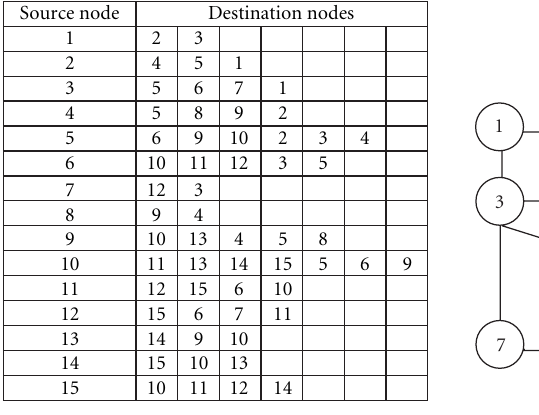
(b) Undirected graph of the network (STG)